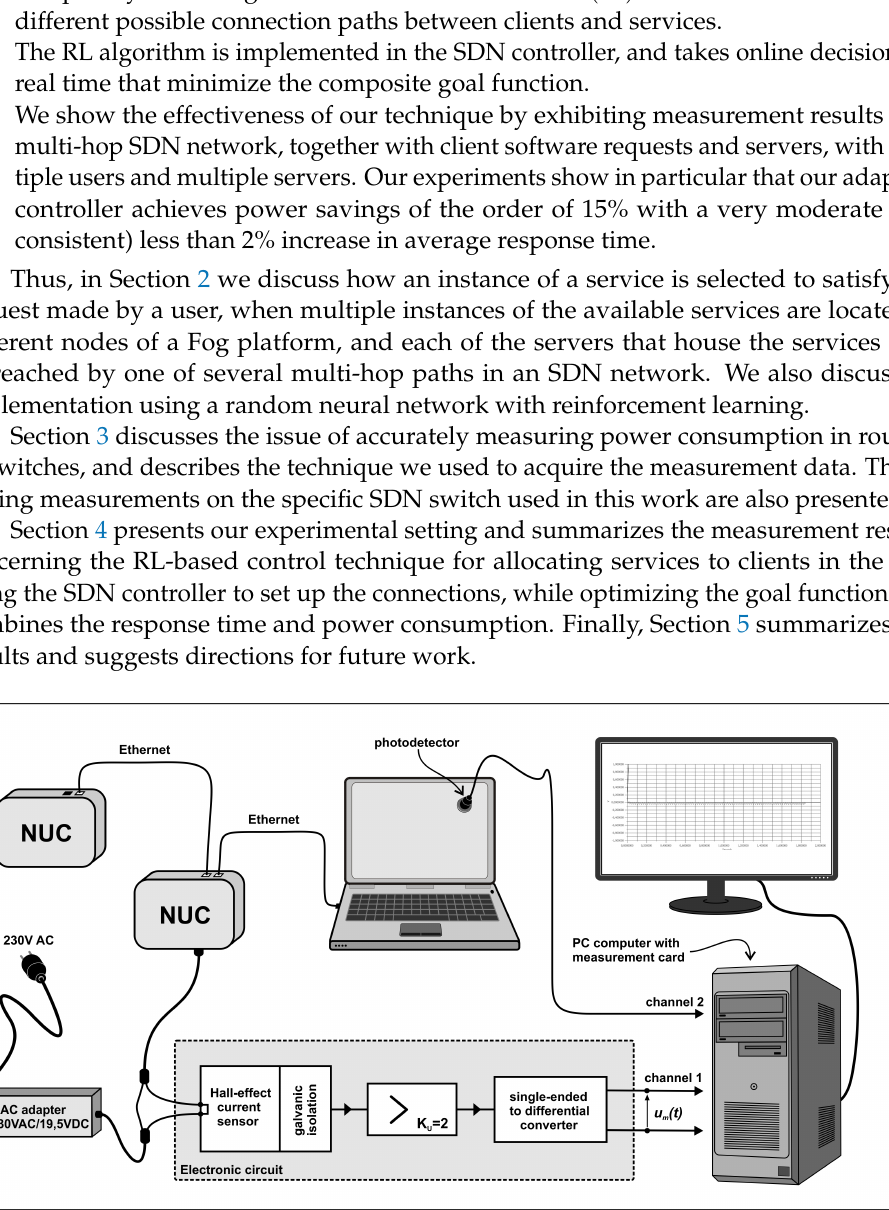
Figure 1. Measurement apparatus, based on the Hall effect, for power versus traffic characteristics of NUC hardware used for each SDN